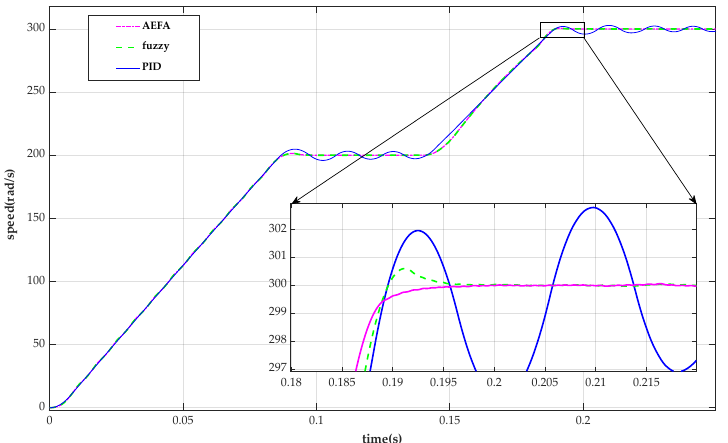
Figure 13. Speed response of BLDC motor for three controllers under variable setting speed condition.